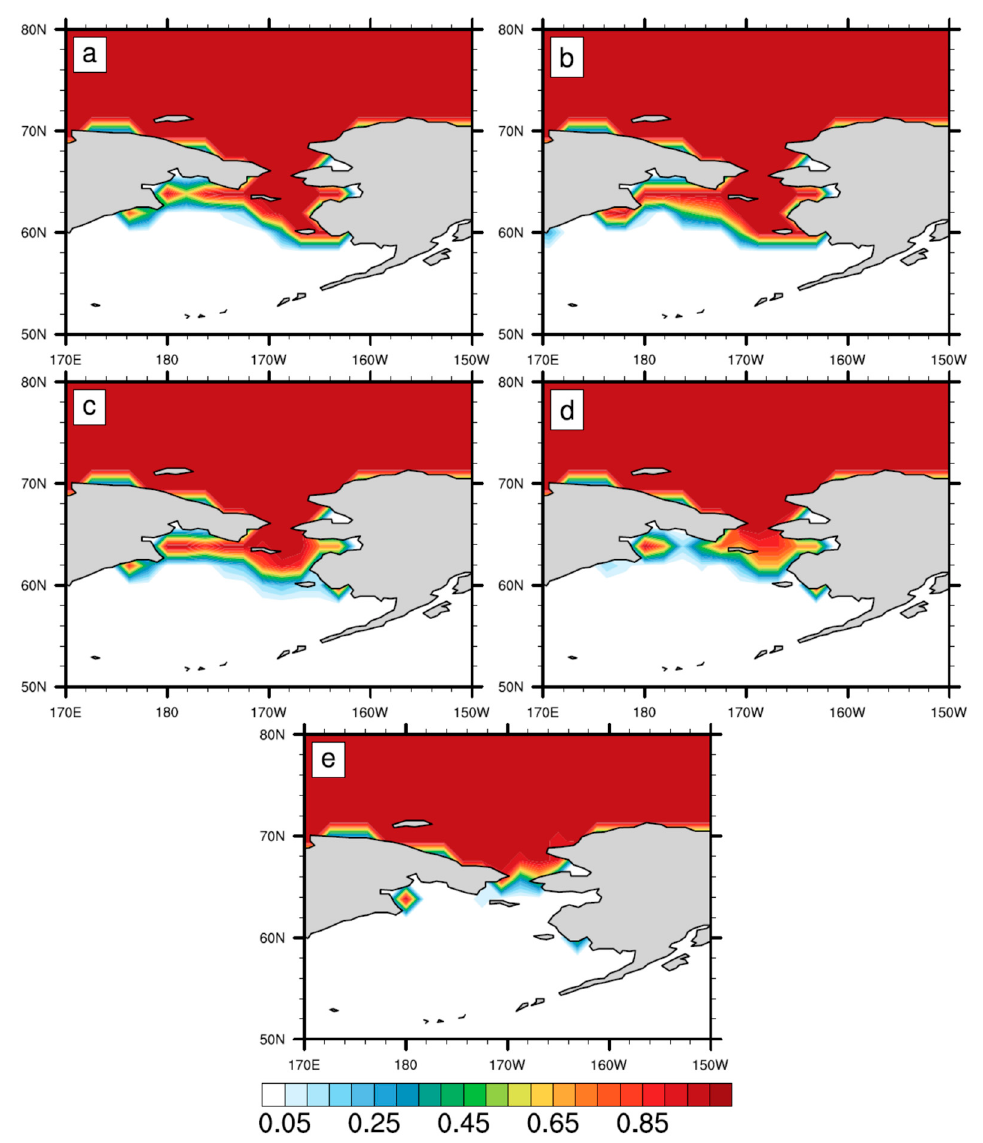
Figure 11. Sea ice concentration in the Bering Sea in ( a ) 1–15 January; ( b ) 16–31 January; ( c ) 1–14